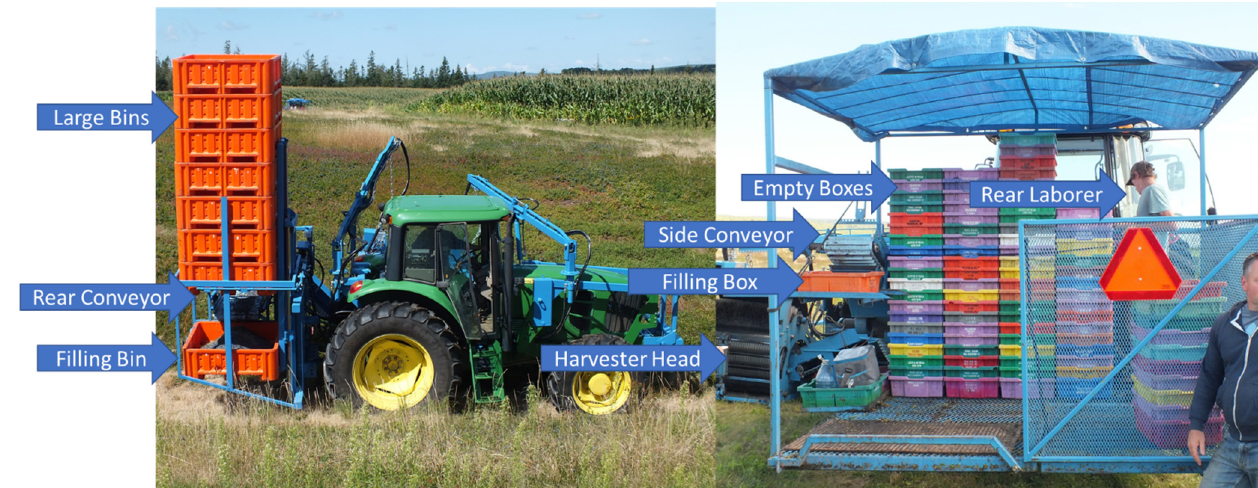
Figure 1. Image of semi-automated bin handling system ( left ) and small box handling system ( right ) on. Doug Bragg Enterprises (DBE) Wild Blueberry Harvesters